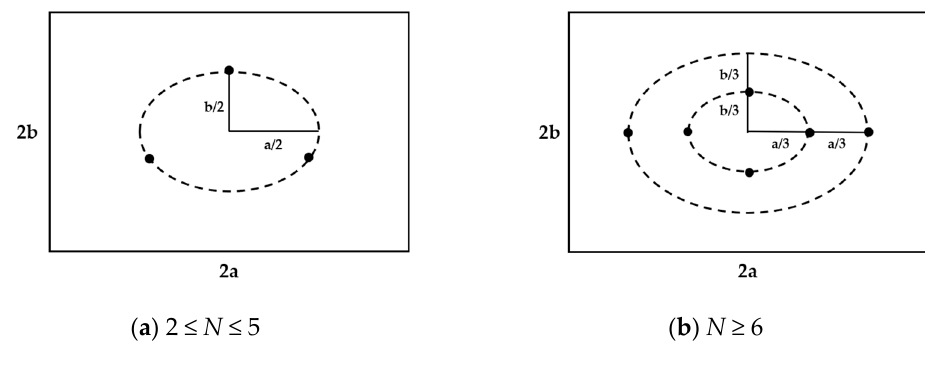
Figure 3. Initial site selection.